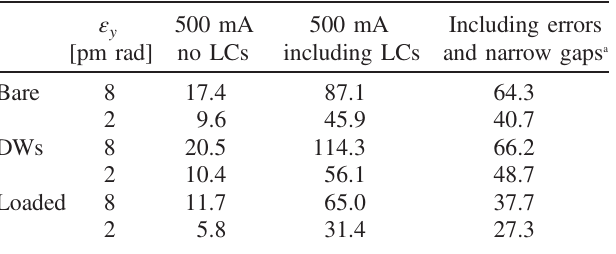
TABLE II. Touschek lifetime (in hours) in the MAX IV 3 GeV storage ring for different settings of coupling and three lattice configurations (identical to those used in Table I). A stored current of 500 mA and rf cavities set to maximum voltage were assumed. The last column shows results where imperfections (misalignments, field and multipole errors) and reduced vertical acceptance from IVUs have been included in the